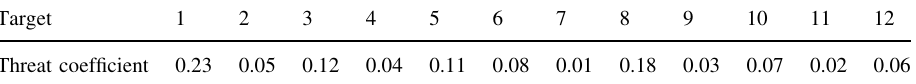
Table 7 Target threat coefficient for case 4